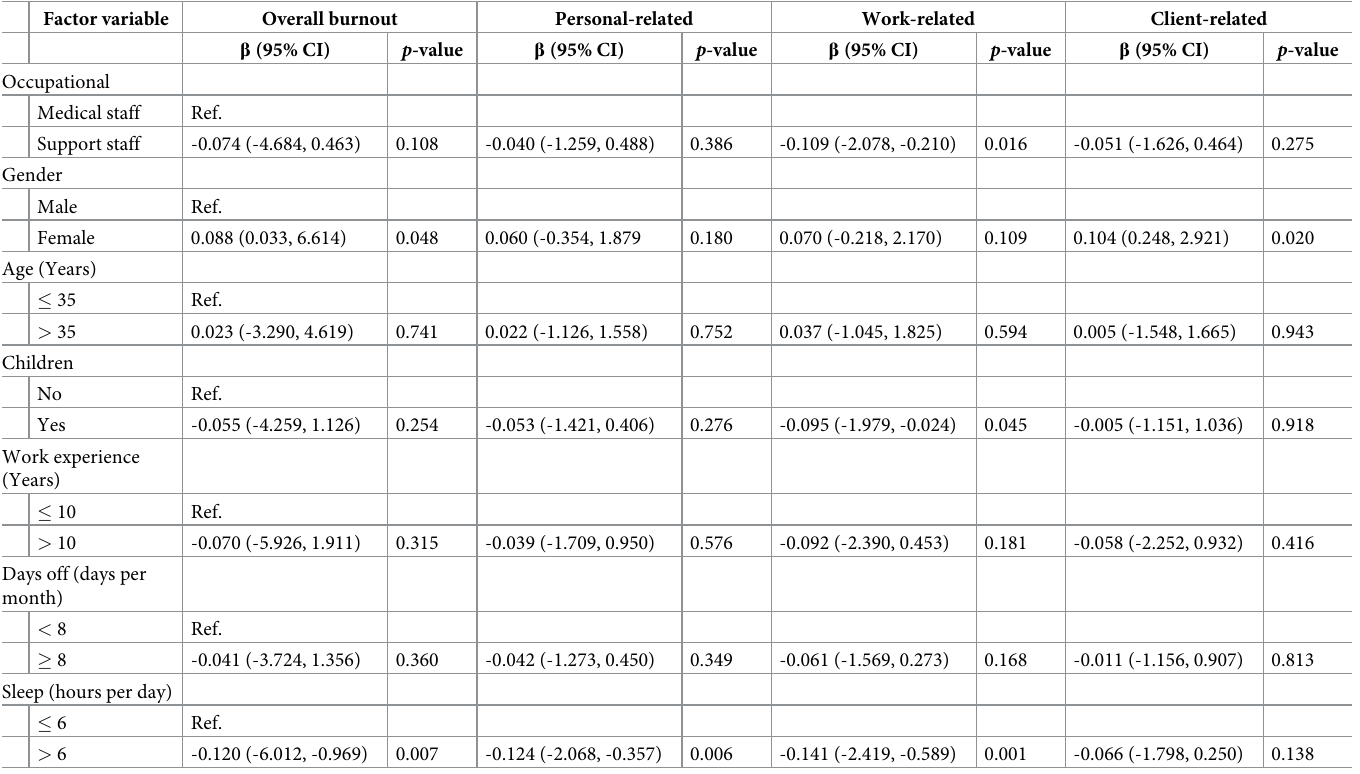
Table 4. Factor variables associated with burnout among healthcare